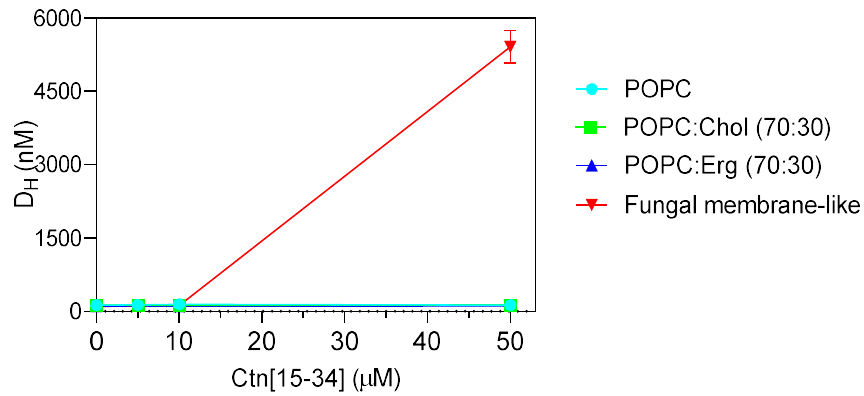
Figure 4. Hydrodynamic diameter (D H ) of the different lipid vesicles (200 µM total lipid concentration) exposed to increasing concentrations of Ctn[15–34]. Extensive aggregation is clear at the concentration of 50 µM for the fungal membrane-like lipid composition. Data are presented as mean ± SD of three independent replicates.